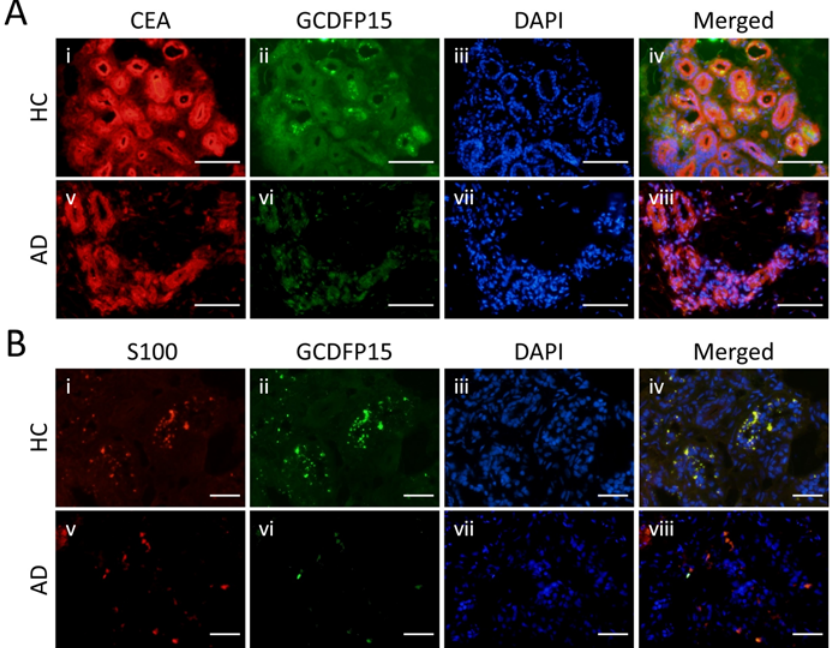
Fig 3. Distribution patterns of GCDFP15, CEA, and S100 protein in eccrine gland secretory coil. (A) Double staining of CEA and GCDFP15 in the eccrine gland secretory coil. The expression of CEA is observed in whole eccrine gland secretory coil cells. (B) Double staining of S100 protein and GCDFP15. The expression of S100 protein is observed in a part of eccrine gland secretory coil cells as granular pattern. Colocalization of S100 protein and GCDFP15 is shown in yellow in the merged image. Bars indicate 50 μ m.